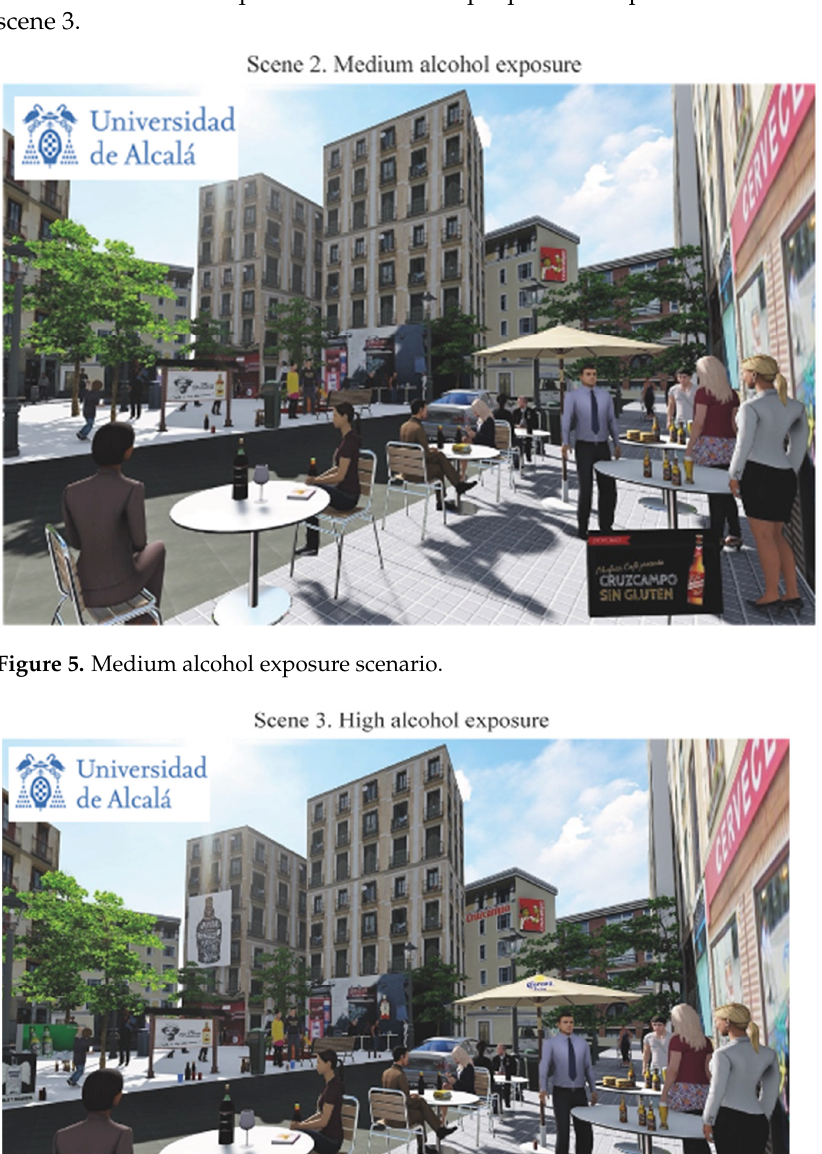
Figure 5. Medium alcohol exposure scenario.